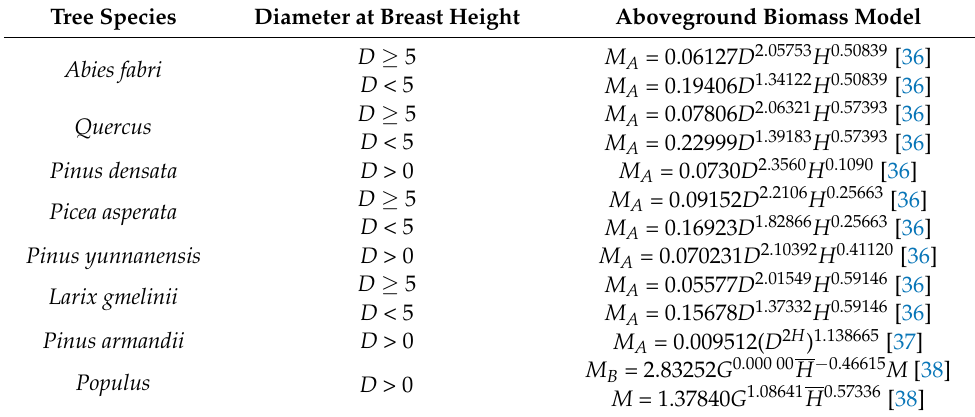
Table 1. Biomass model of main tree species in Shangri-La City. Tree